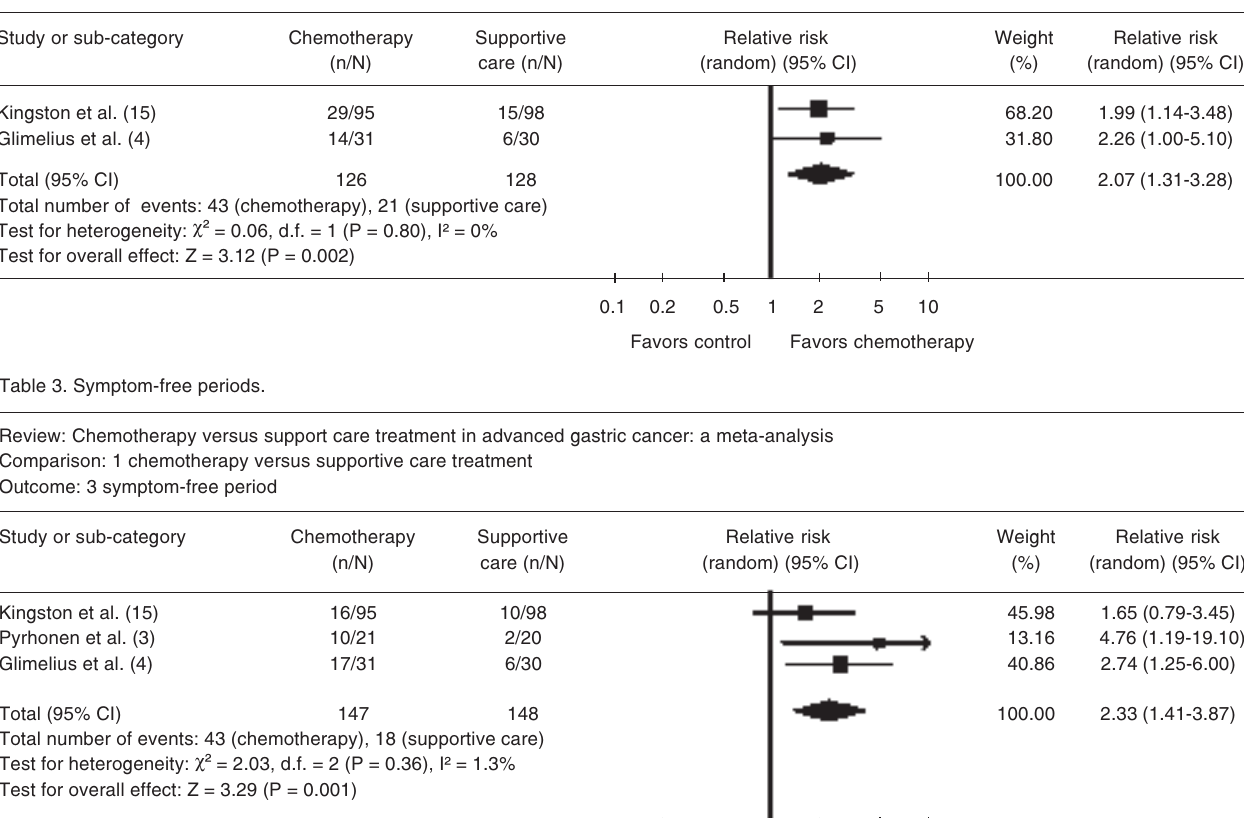
Table 2. Improved quality of life.